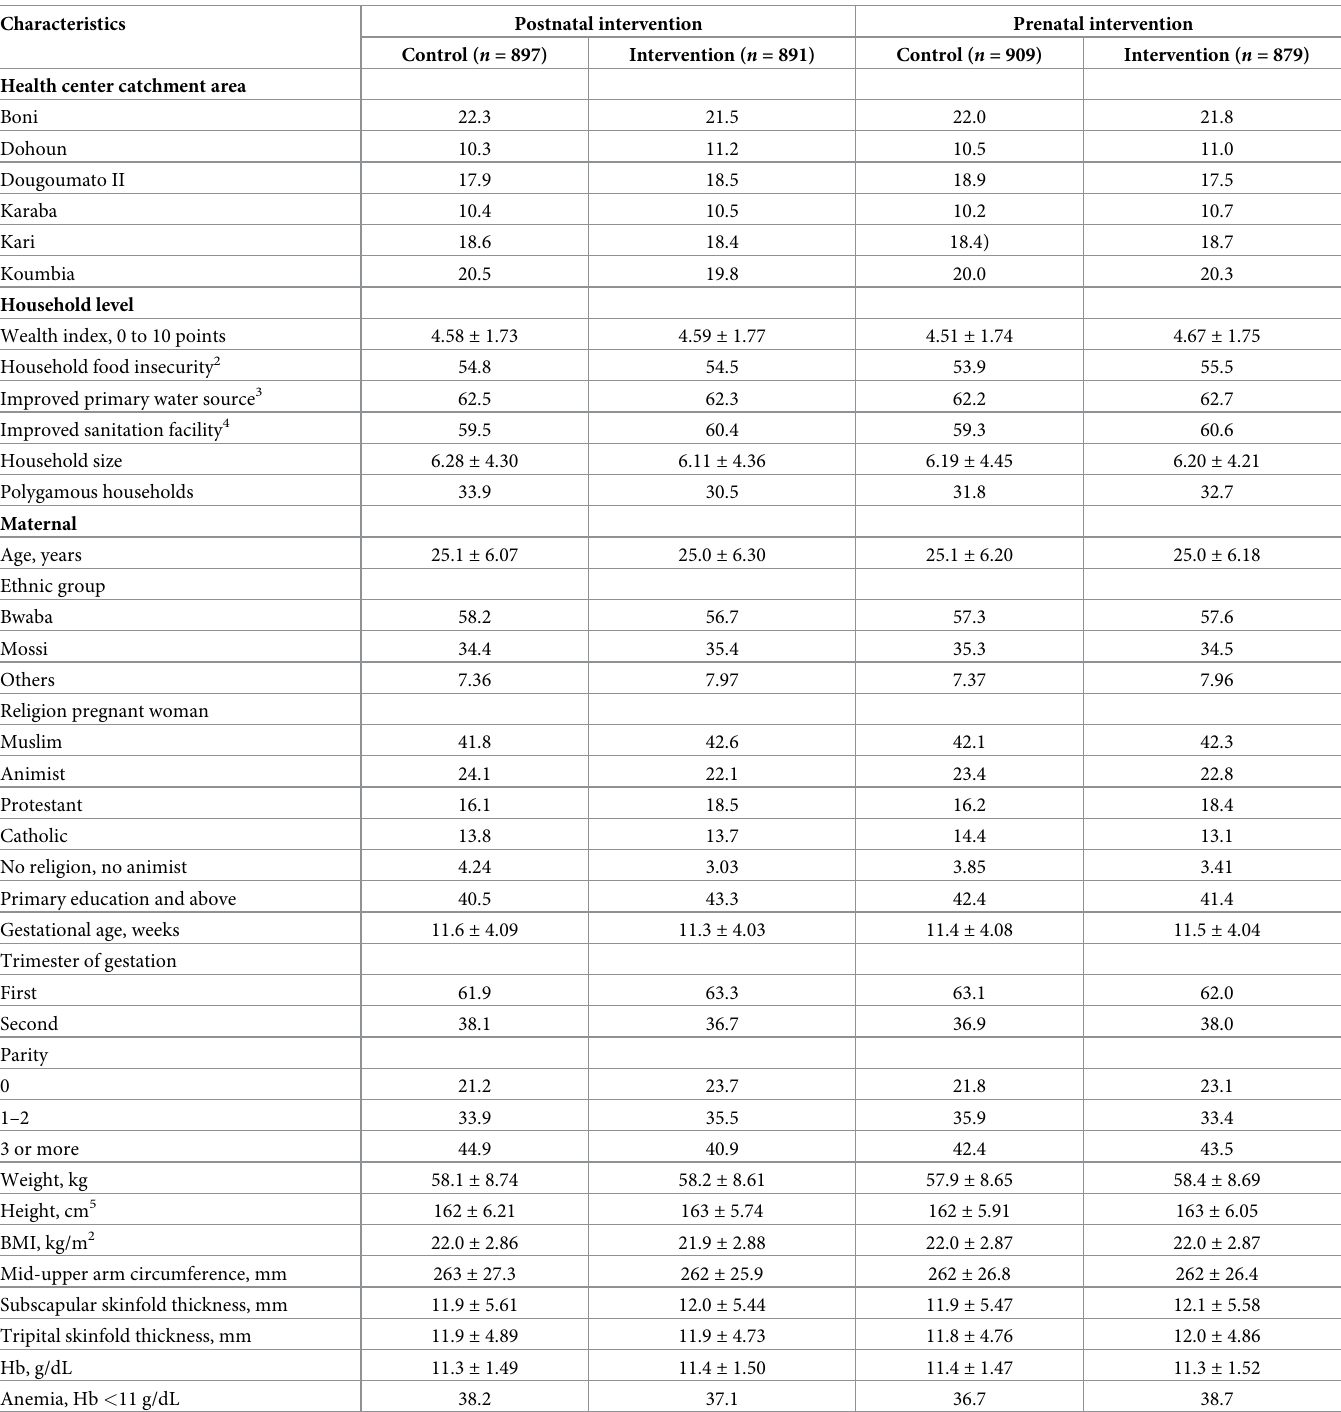
Table 1. Baseline characteristics of study participants by post- and prenatal intervention arms 1 .